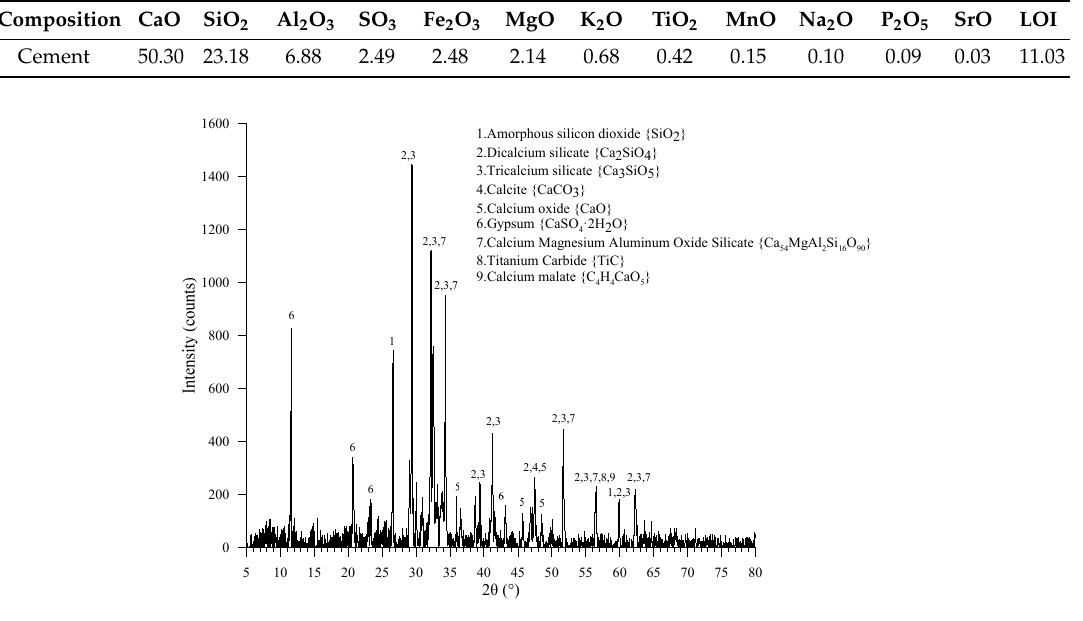
Figure 2. X-ray Diffraction results of cement used. Figure 2. X-ray Di ff raction results of cement